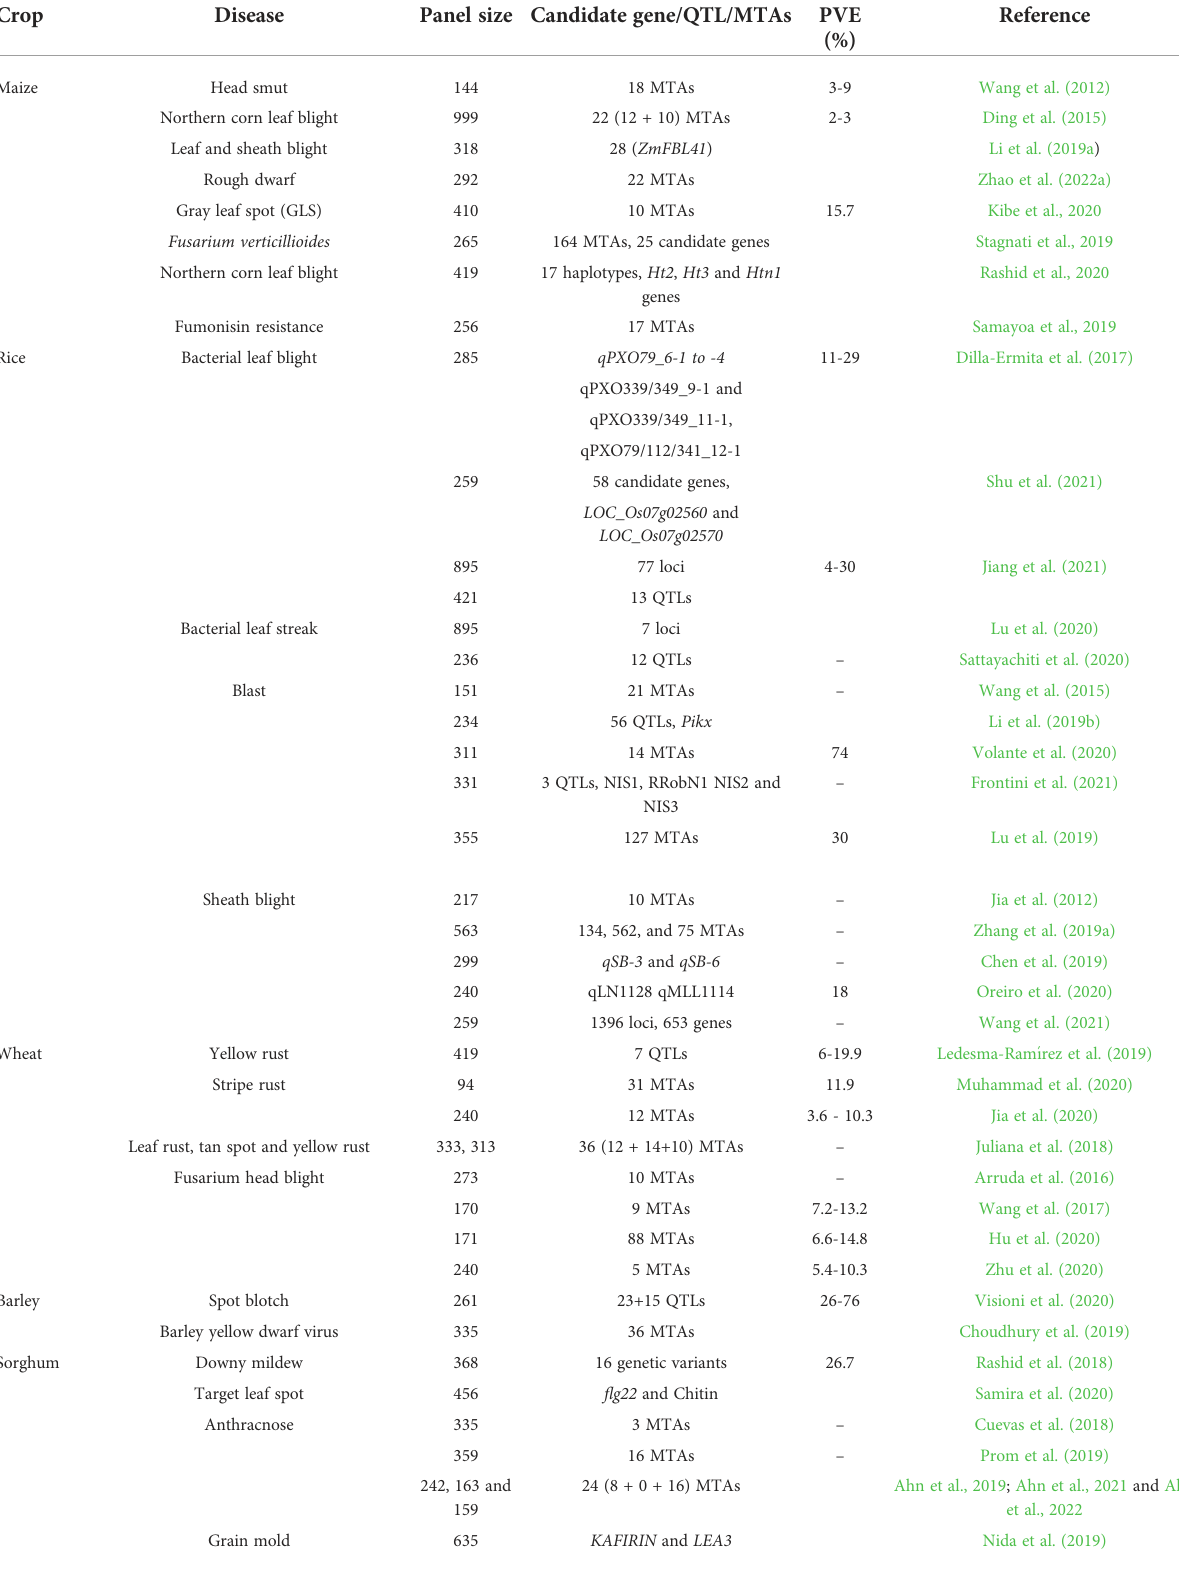
TABLE 1 Summary of MTAs or candidate genes identi fi ed for disease resistance in major